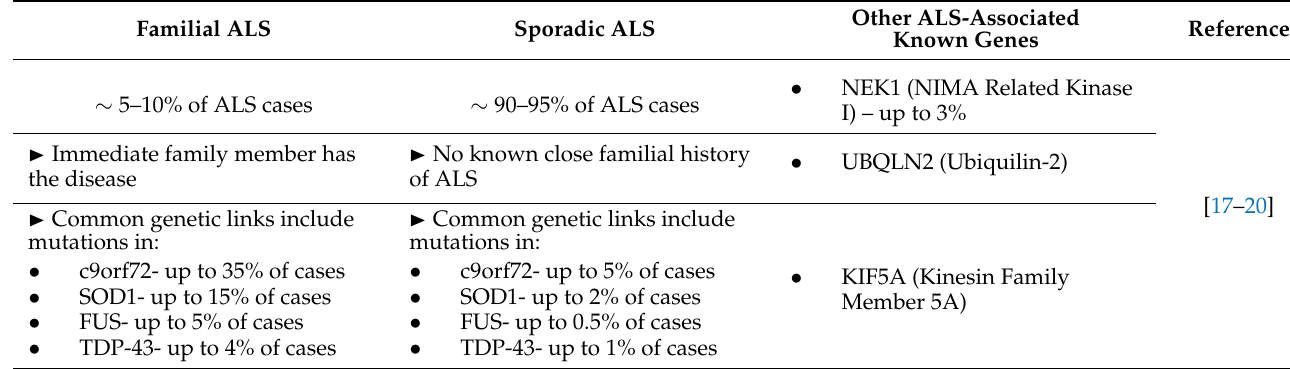
Table 2. The types of ALS and brief characteristics.